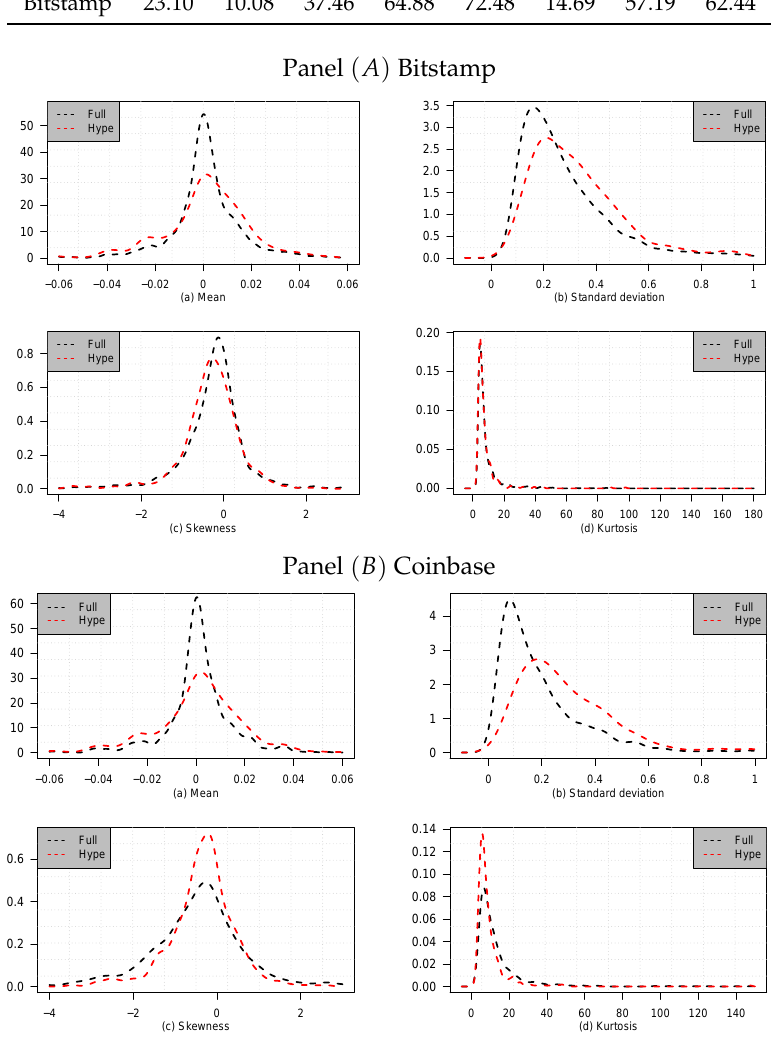
Figure 1. Gaussian kernel densities estimated using 5 min returns over the daily mean (a); standard deviation (b); skewness (c) and excess of kurtosis (d) coefficients for Bitstamp (panel A ) and Coinbase (panel B ). Results are reported for the full sample (black) and for the Hype period